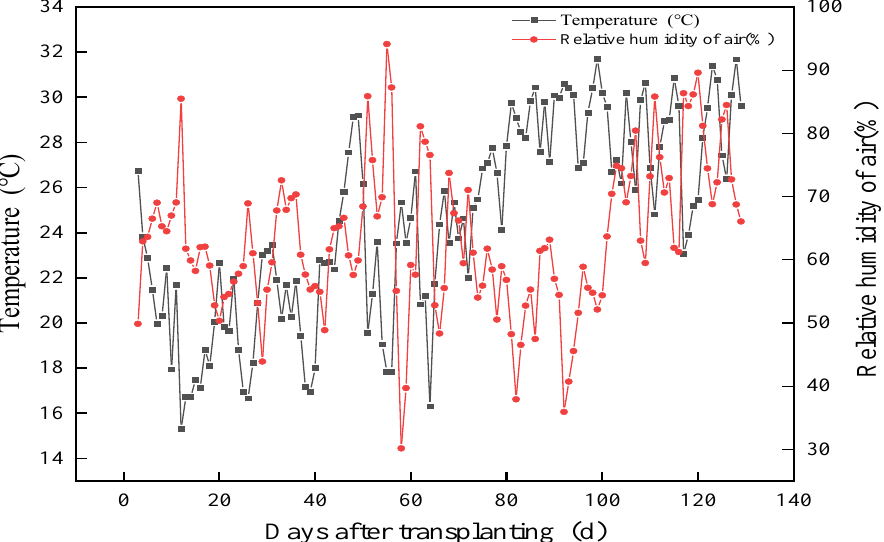
Figure 2. Daily mean temperature and relative humidity of air during the experimental period of tomato in 2019.